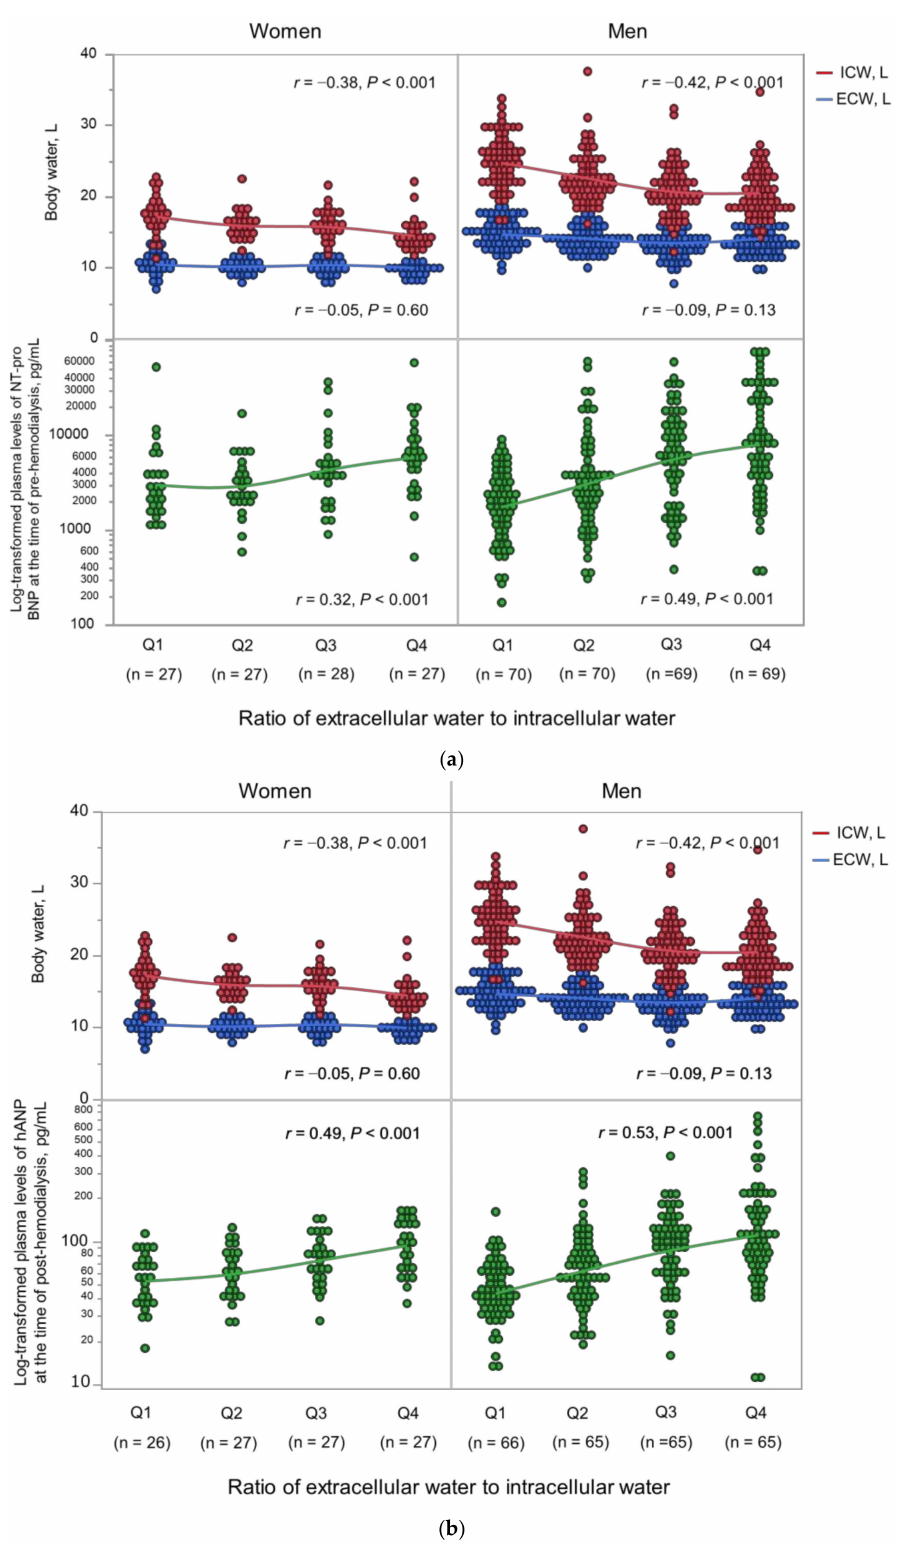
Figure 1. ( a ) Body fluid composition and NT-proBNP by the ECW/ICW ratio quartiles. ( b ) Body fluid composition and hANP by the ECW/ICW ratio quartiles. ECW, extracellular water; ICW, intracellular water; NT-proBNP, pre-dialysis N -terminal pro-B-type natriuretic peptide; hANP, post- dialysis human atrial natriuretic